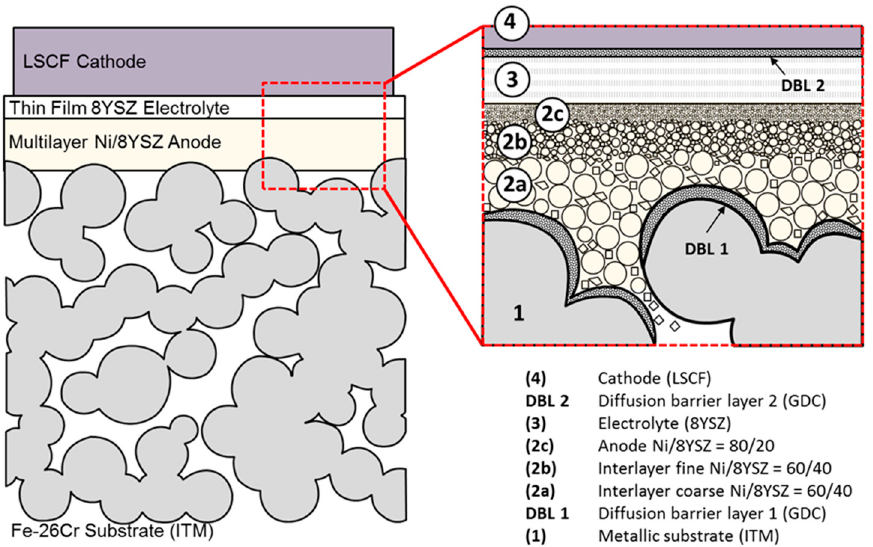
Figure 9. Schematic representation of the Plansee SE MSC. Ratios given for the composition of the anode in (2) are in weight percent.